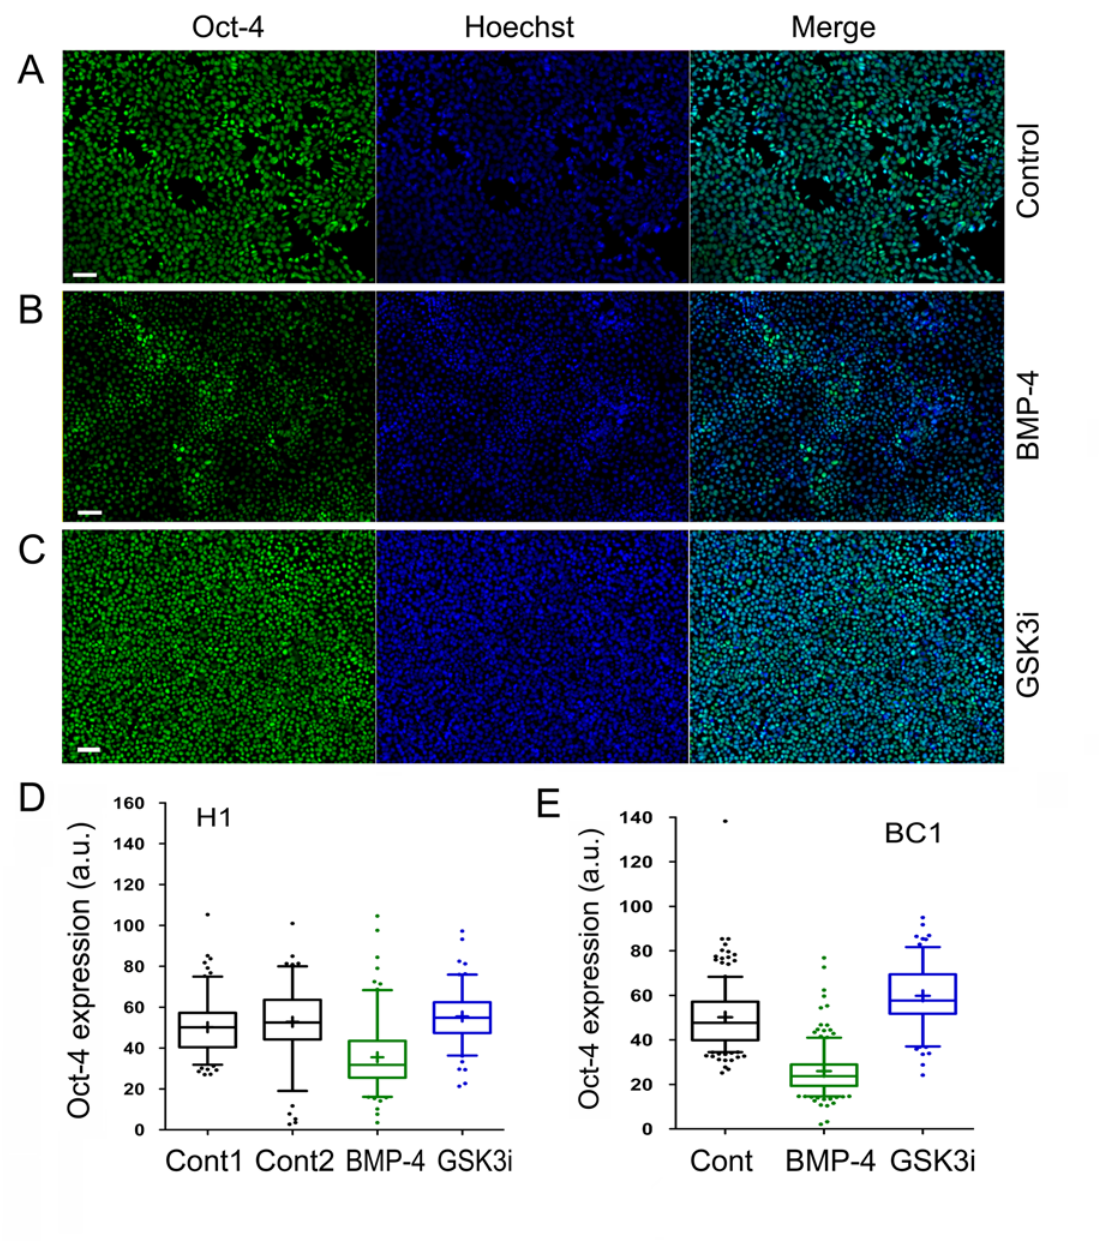
Fig 4. Immunofluorescence analysis of the expression of the pluripotent marker Oct-4 in human pluripotent stem cells (hPSCs). Oct-4 expression in H1 control cells (A), H1 cells treated with 100 ng/mL of BMP-4 (B), and H1 cells treated with 3 μ M GSK3i (CHIR99021) for 48 hours (C). The cellular genomic DNAs were stained by the Hoechst 33342 dye (Hoechst). The images were collected with a fluorescence microscope (Zeiss). ( D and E ) Box-and-Whisker plots of Oct-4 expression (with 5 – 95% percentile) in both H1 and BC1 cells under the indicated treatments. Control 2 (Cont2) in D is an additionally untreated control of H1 cells. The plus signs (+) in the plots indicate the location of the mean values determined from 116 to 150 individual cells by the ImageJ program. One of two independent experiments is shown. Scale bars represent 50 μ